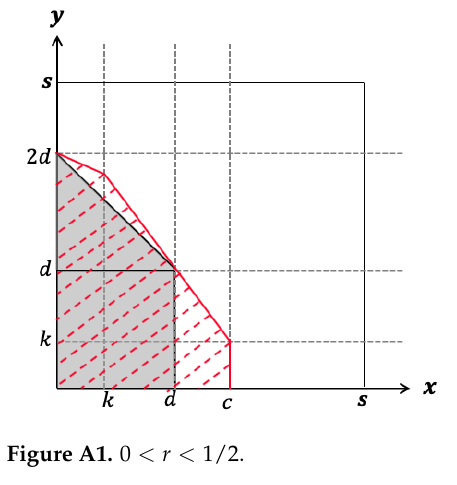
Figure A1. 0 < r < 1/2.